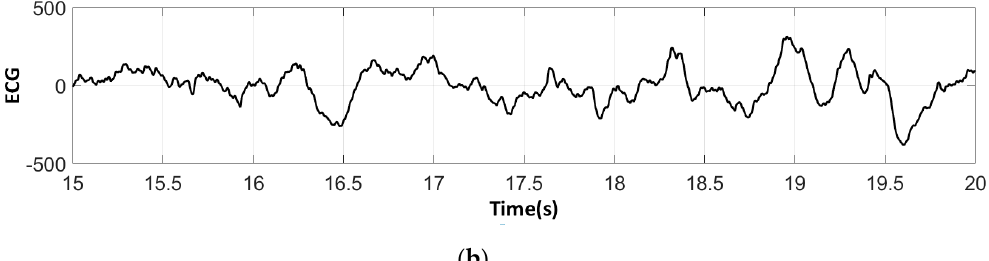
Figure 17. ECG signal obtained by cotton/Lycra electrodes with 6.3 wt.% PEDOT:PSS: ( a ) before washing; ( b ) after 50 washing cycles.